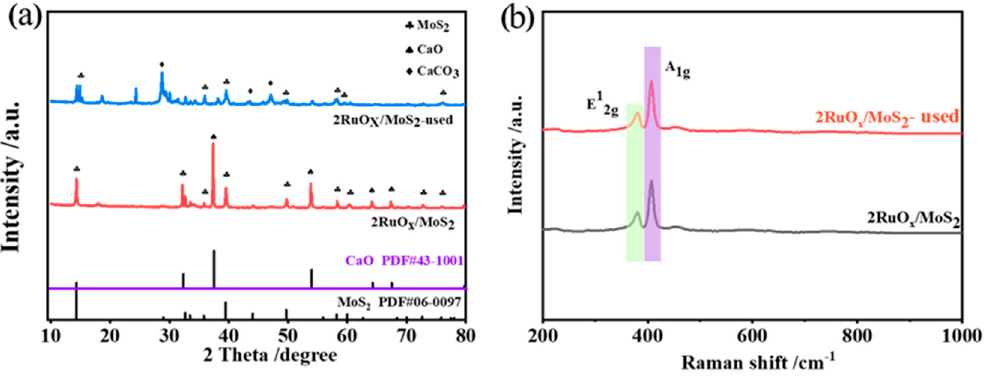
Figure 3. ( a ) XRD patterns and ( b ) Raman spectra of the fresh and used 2RuO x /MoS 2 +CaO catalyst.